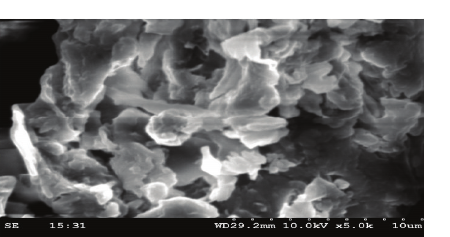
Figure 3: Scanning electron microscopic photograph of